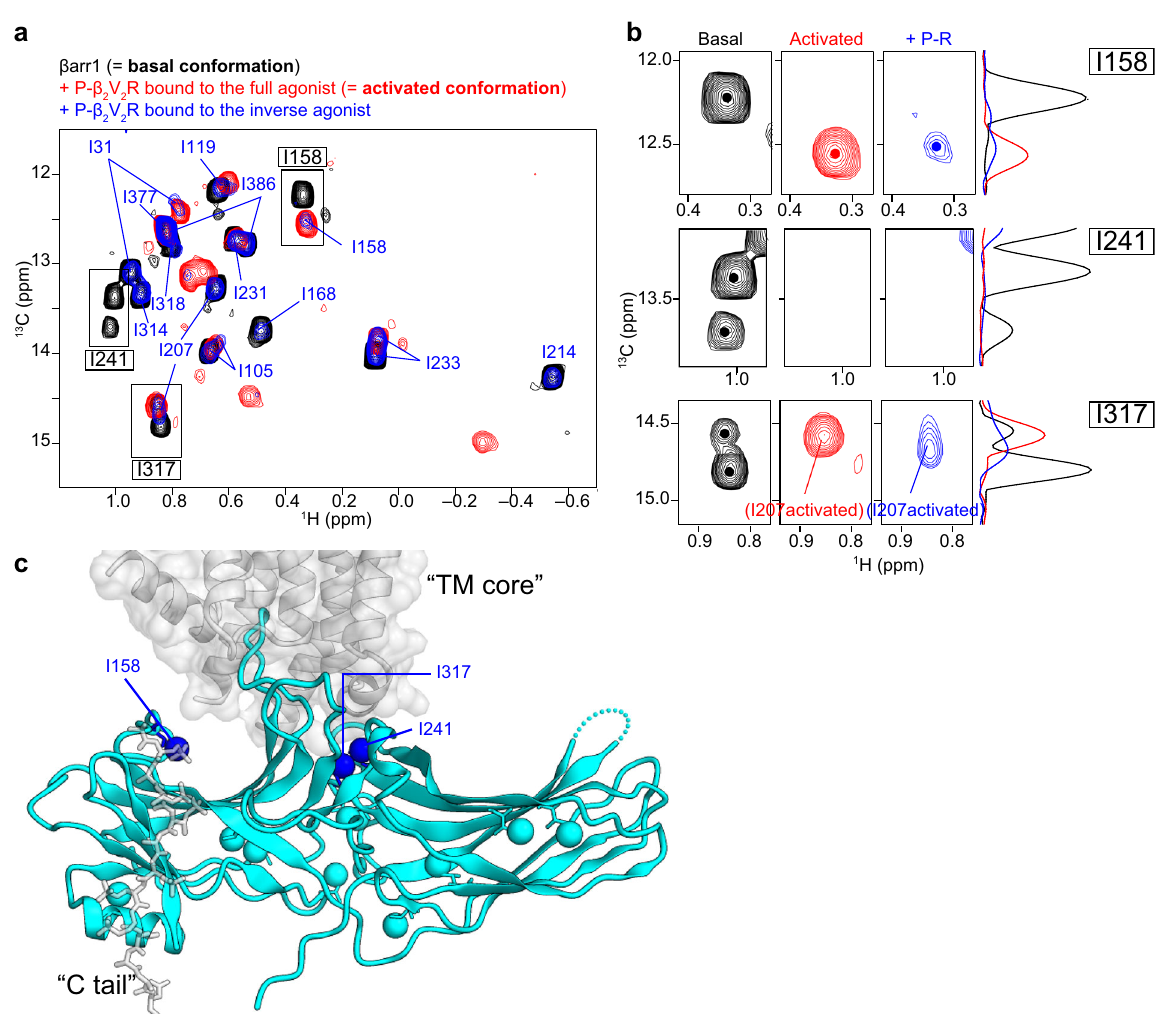
Fig. 3 Conformational change of β arr1 upon binding to phosphorylated β 2 V 2 R bound to the inverse agonist. a Overlay of the 1 H- 13 C HMQC spectra of [u- 2 H, Ile δ 1- 13 C 1 H 3 ] β arr1 in the basal state (black), the complex with phosphorylated β 2 V 2 R in rHDLs bound to the full agonist (red), and the complex with phosphorylated β 2 V 2 R in rHDLs bound to the inverse agonist (blue). b Magni fi ed views of resonances from I158 (upper row), I241 (middle row), and I317 (lower row) in the basal conformation (black), the activated conformation (red), and in the complex with phosphorylated β 2 V 2 R bound to the inverse agonist (blue). The 13 C 1D projections of selected regions are shown on the right of the spectra. The resonance from I158 exhibited a chemical shift change, and the resonances from I241 and I317 disappeared upon the addition of phosphorylated β 2 V 2 R in rHDLs bound to the inverse agonist. The split of the resonances from I241 and I317 in the basal state indicated the local conformational exchange, which is distinct from the exchange between the basal and activated conformations. c Mapping of the methyl groups adopting the activated conformation, in the complex of phosphorylated β 2 V 2 R bound to the inverse agonist, on the structure of β arr1 in complex with β 1 AR-V2R 6P and Fab30 (PDB ID: 6TKO). Methyl groups exhibiting chemical shift changes or signal disappearance upon binding to phosphorylated β 2 V 2 R in rHDLs bound to the inverse agonist are